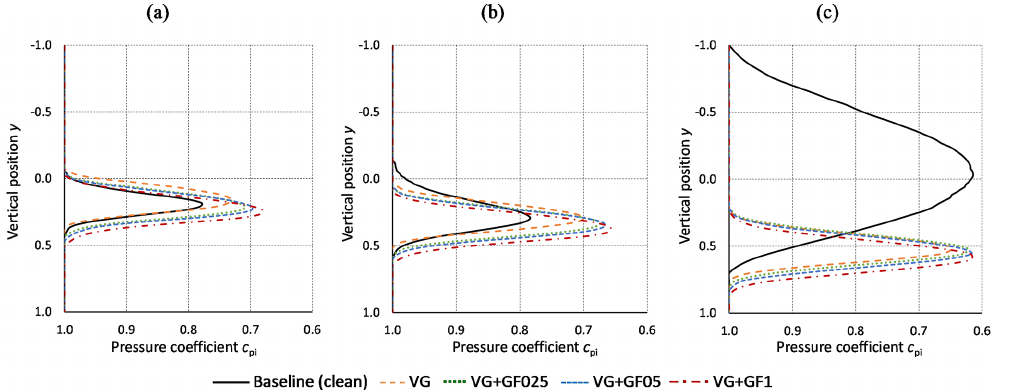
Figure 12. DU97W300. Pressure coefficients over vertical wake rake positions in the clean case. Vortex generators and Gurney flaps. (a) α opt = 9 . 5 ◦ . (b) α cl , max = 12 . 6 ◦ . (c) α = 16 . 5 ◦